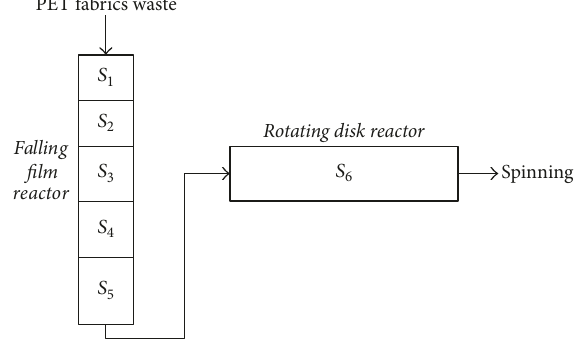
Figure 2: Schematic of the falling film-rotating disk combined reactor with multiple